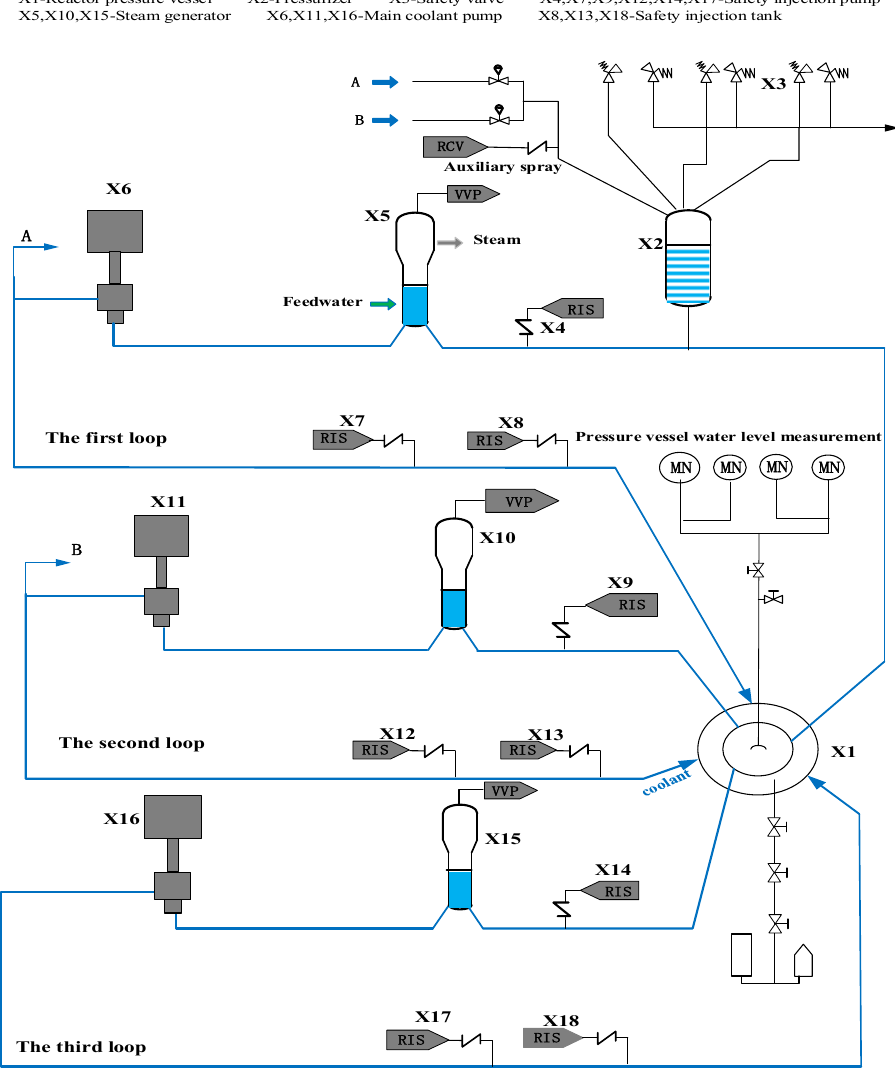
Figure 1. Schematic diagram of the MCS.